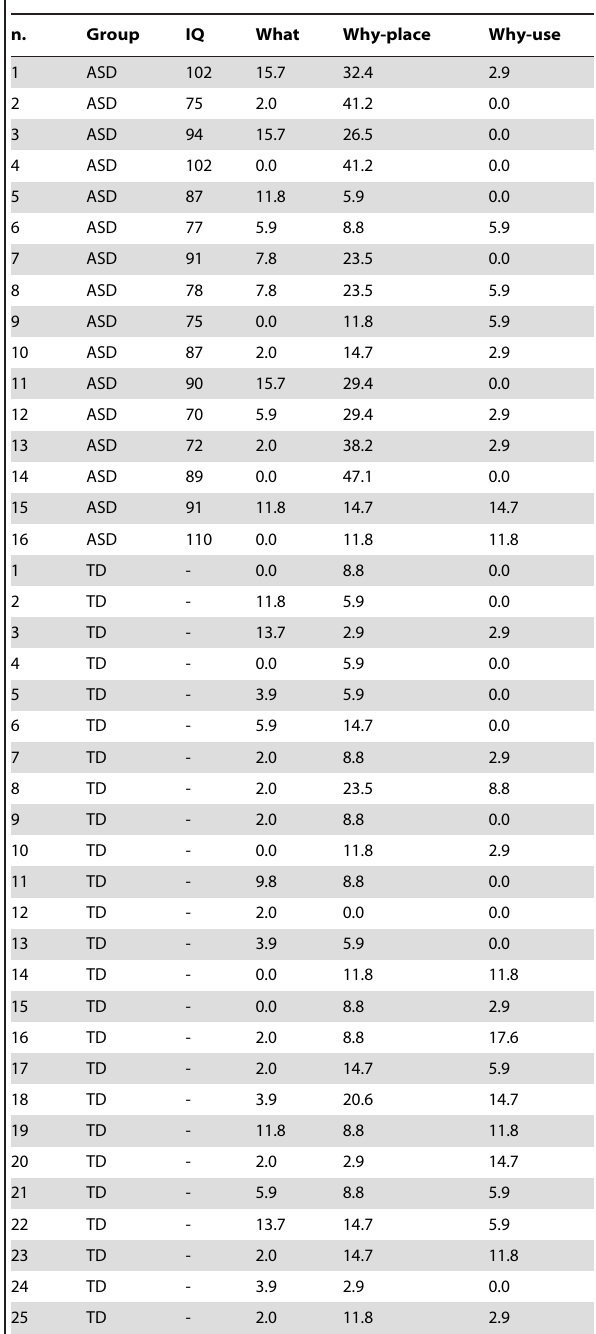
Table 2. Individual error rates expressed as percentages for all participants in the Experiment